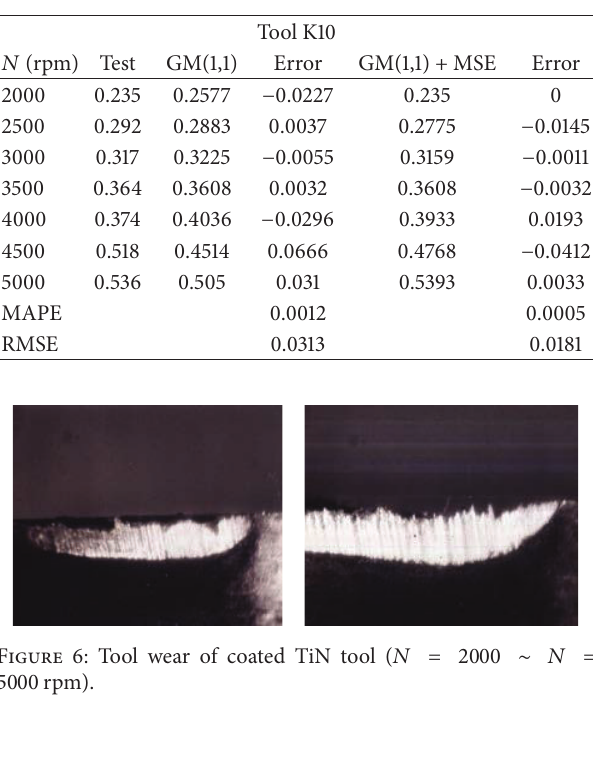
Table 1: Comparison sheet of the common and the improved grey prediction model.